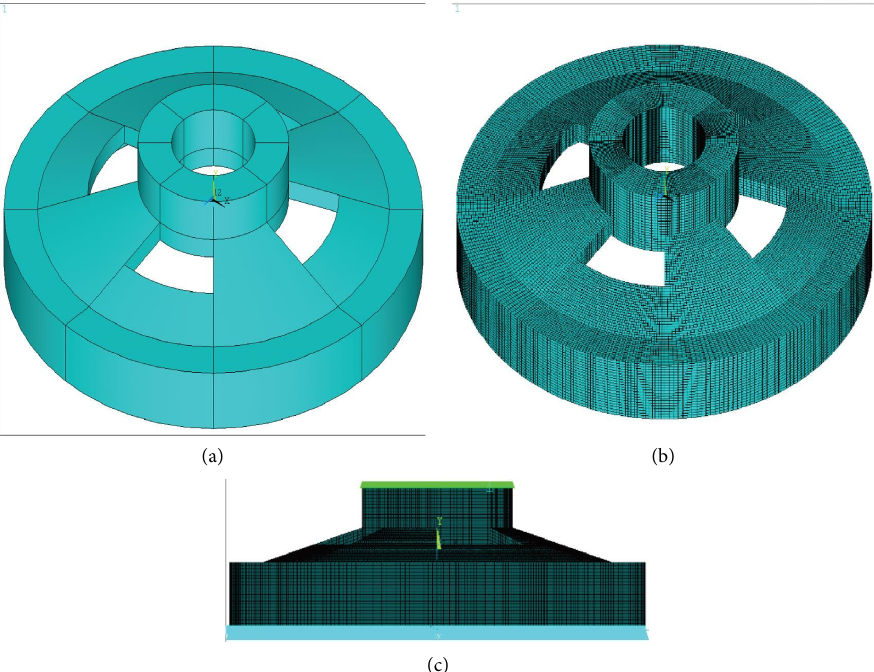
Figure 6: Finite element model of BQZSS: (a) entity model, (b) fnite element model, and (c) constraint conditions.